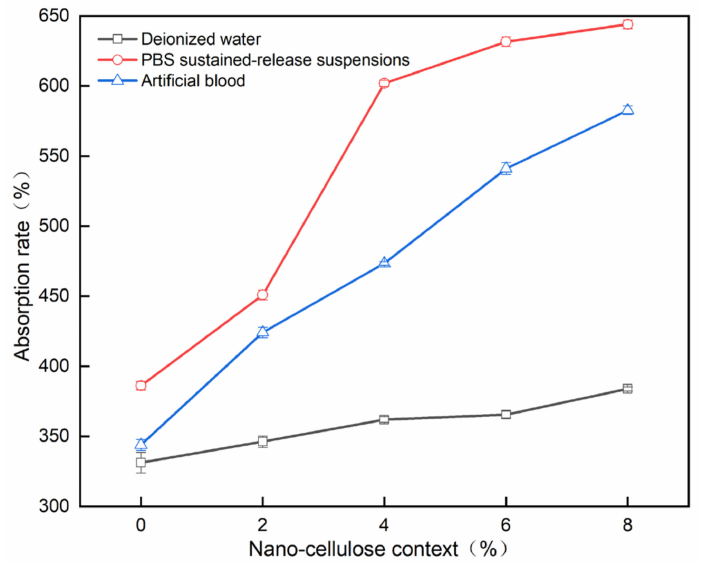
Figure 10. Liquid absorption rate of PVA/NC nanofiber membranes with different content of